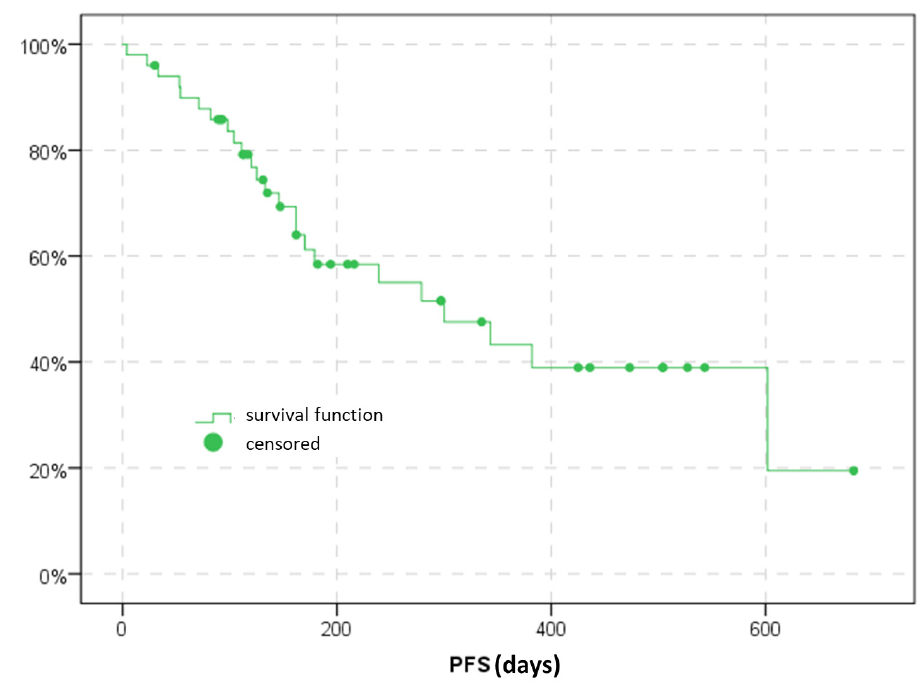
Fig. 2. Progression-free survival - second line